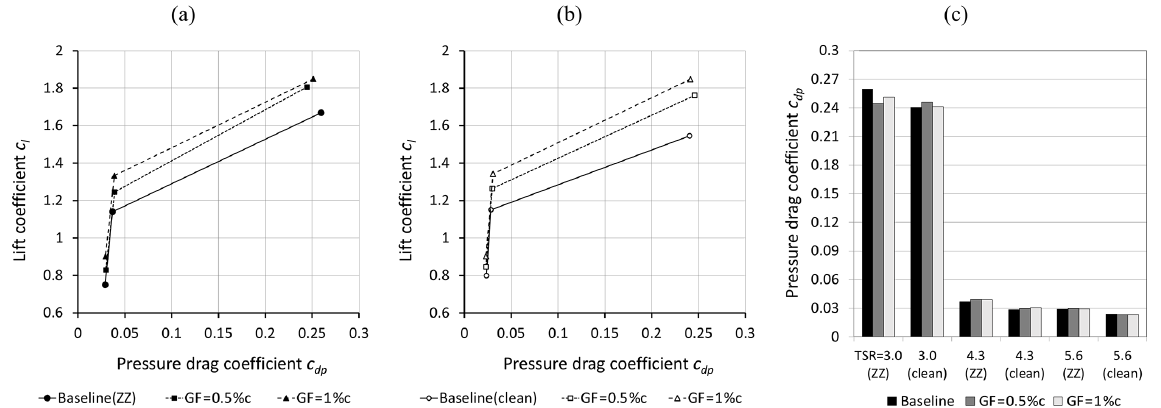
Figure 12. Lift over pressure drag coefficients at r = 0.45 R and ϕ = 270 ◦ . (a) Tripped case. (b) Clean case. (c) Pressure drag coefficients in relation to the corresponding baseline.